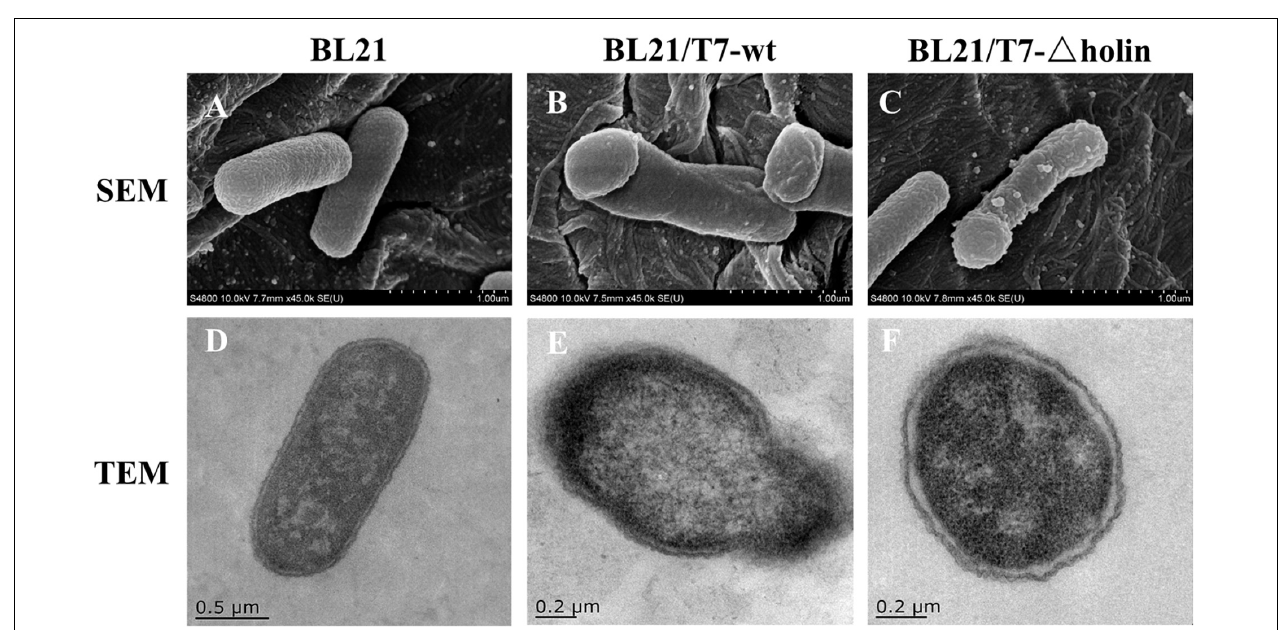
FIGURE 2 | Electron microscopy observation of Escherichia coli BL21 cells infected with T7 phage. (A) SEM of Escherichia coli BL21 cell control. (B) SEM of E. coli BL21 cell infected with T7-wt. (C) SEM of E. coli BL21 cell infected with T7-holin. (D) TEM of E. coli BL21 cell control. (E) TEM of E. coli BL21 cell infected with T7-wt. (F) TEM of E. coli BL21 cell infected with